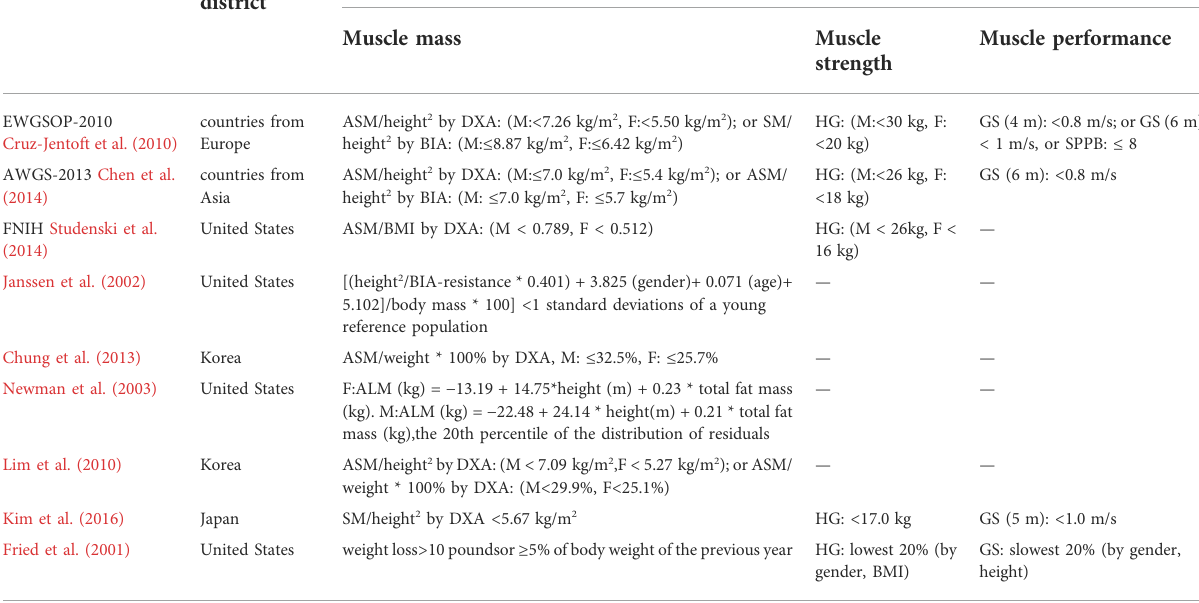
TABLE 2 Different indicators and cut-off points in de fi ning sarcopenia.